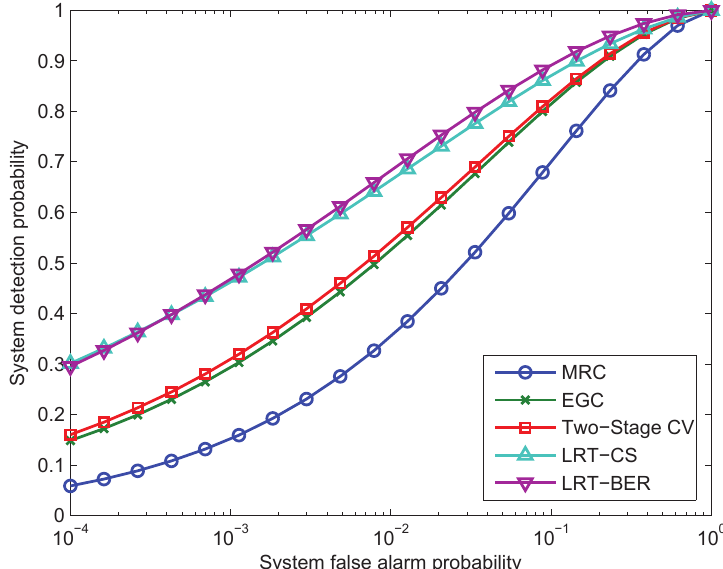
Figure 6. Comparison of ROC curves for LRT-BER, maximum ratio combiner (MRC), equal gain combiner (EGC) and LRT-channel statistics (CS) with six sensors, γ P = 0 . 1 , P = 0 . 6 . BPSK modulation and Rayleigh fading assumption are fa d